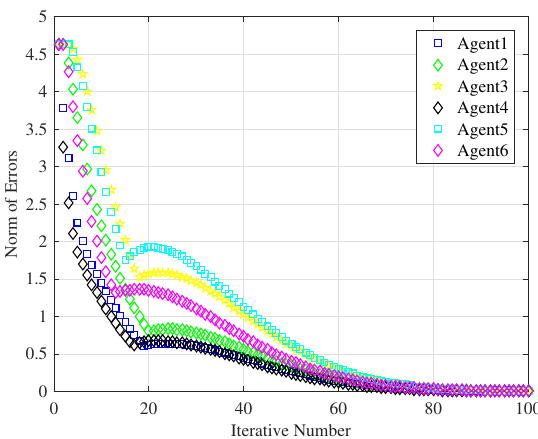
Figure 7. Tracking error of ILC algorithm based on fractional-power error signals with α = 0.85.